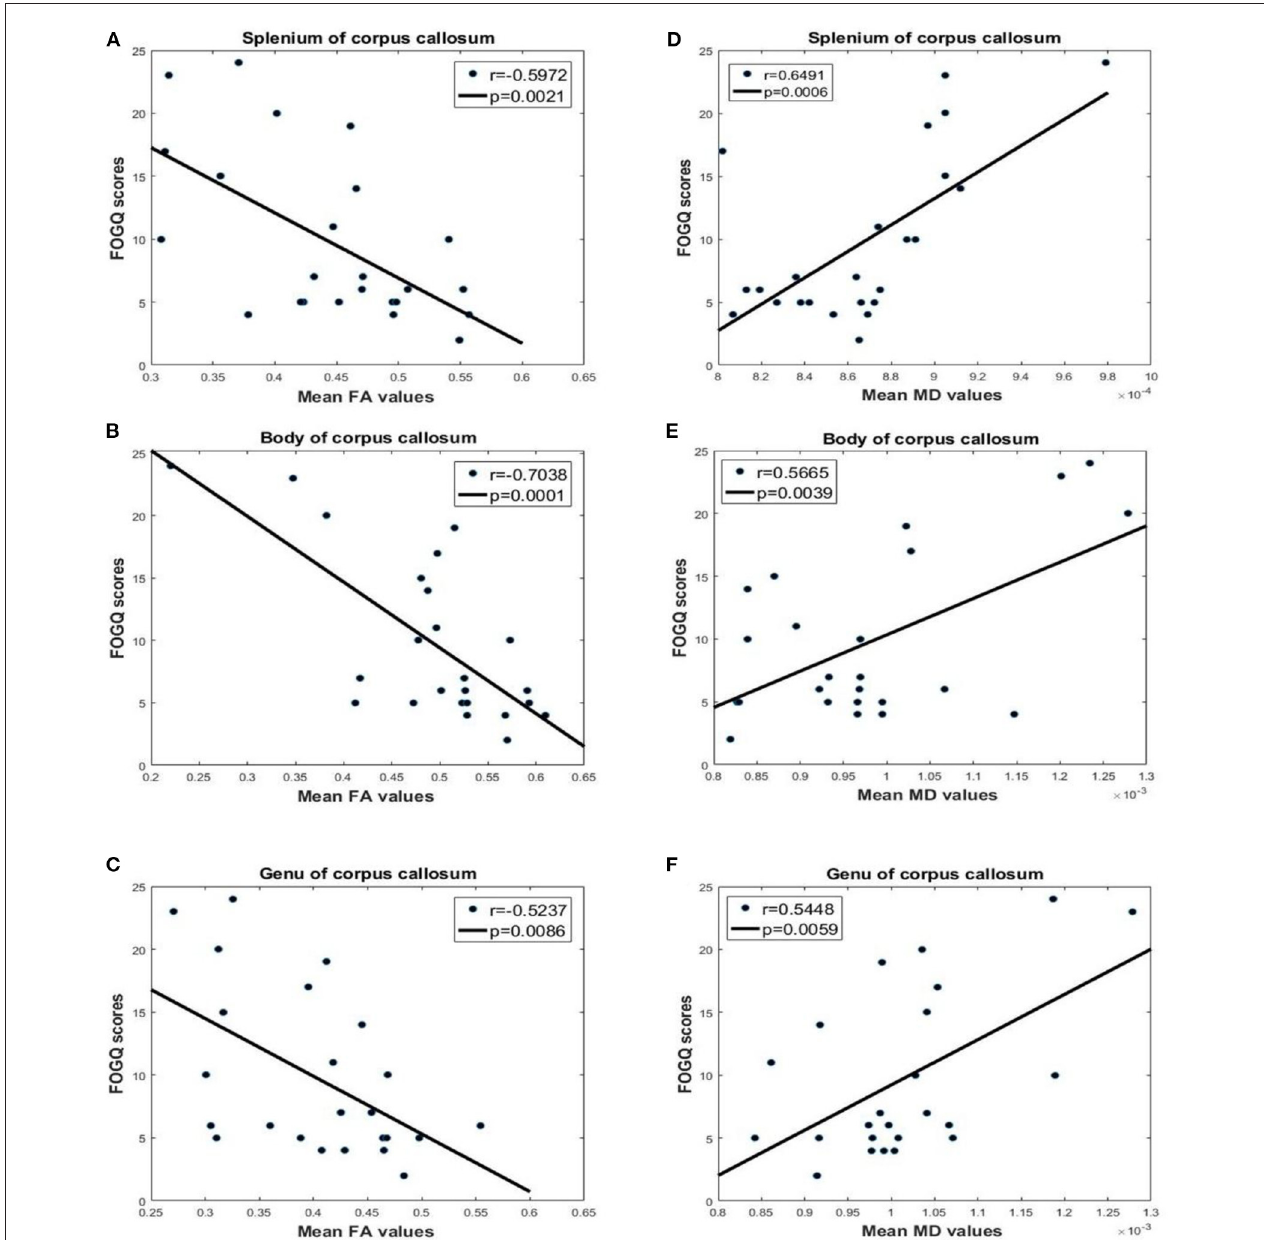
FIGURE 4 | Correlation analysis of FA, MD, and FOGQ scores for the splenium, body, and genu of the CC. FOGQ scores and FA values of the (A) splenium, (B) body, and (C) genu. FOGQ scores and MD values of the (D) splenium, (E) body, and (F) genu.